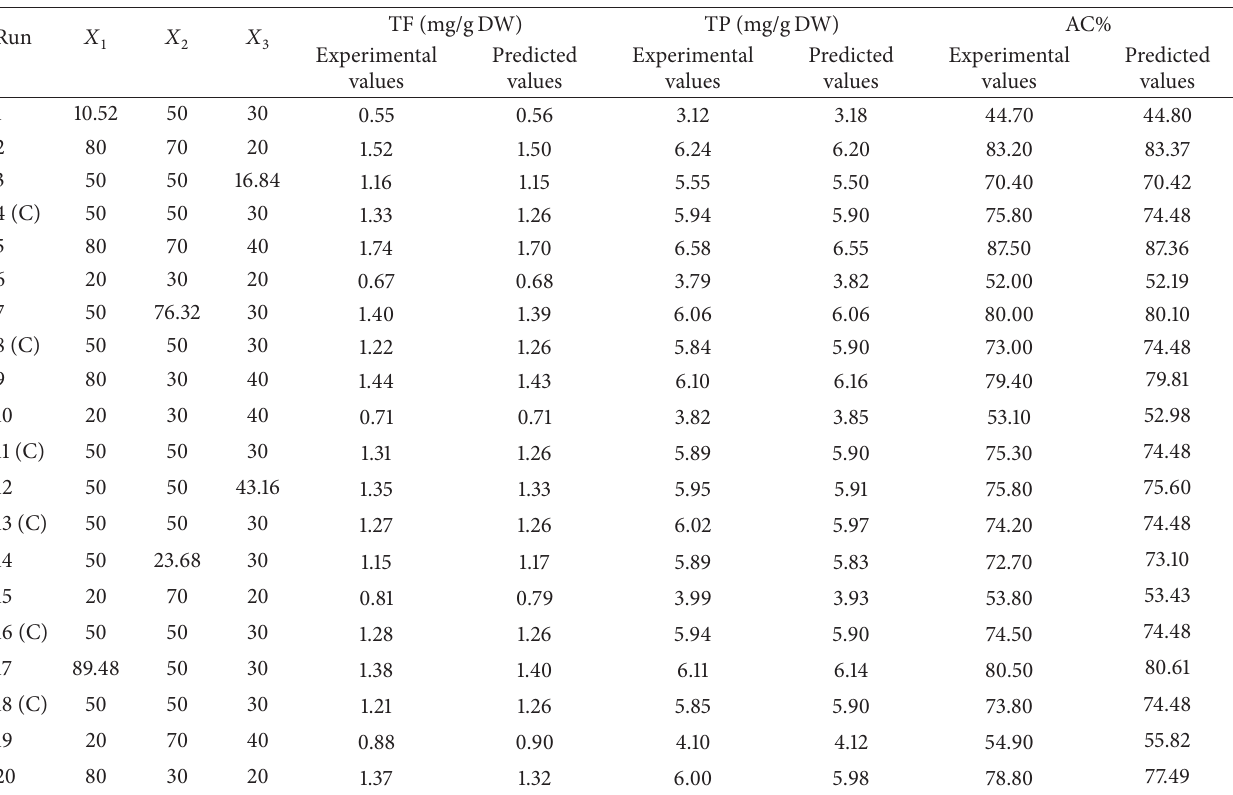
Table 2: The result of experimental and predicted values of reflux extraction of TF, TP, and